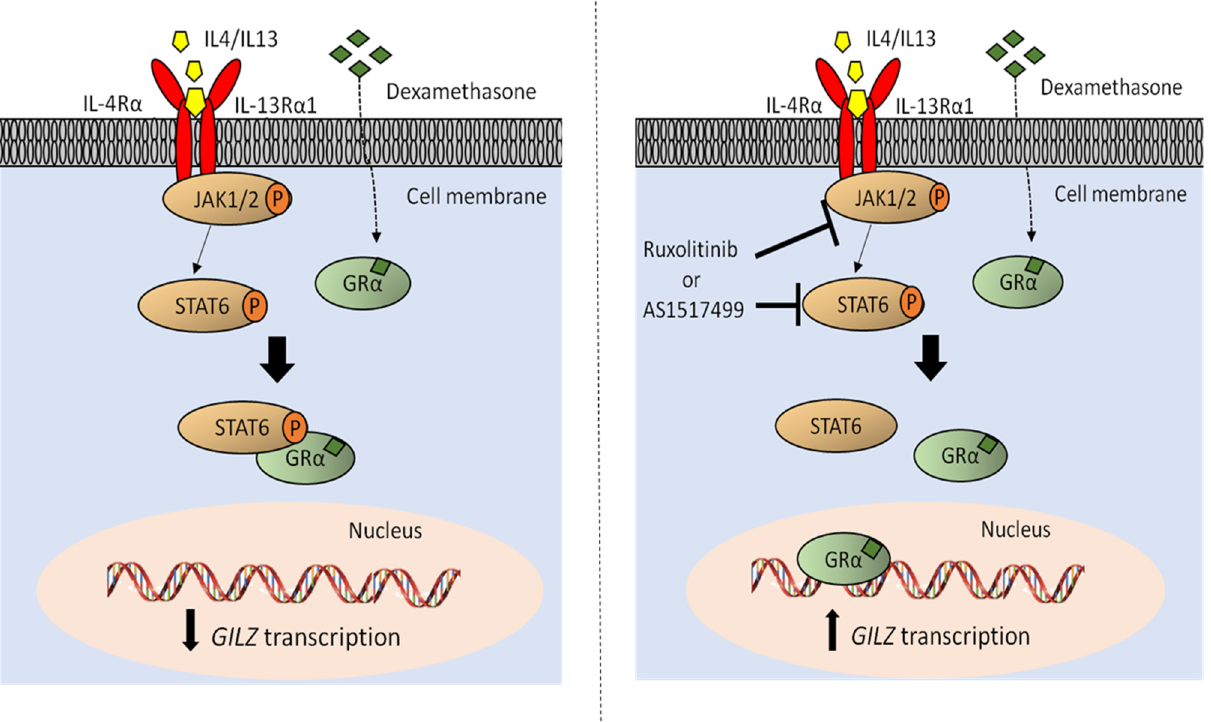
Figure 6. Schematic representation of the JAK1/2-STAT6 pathway and its interaction with GR protein. On the left, the kinases JAK1/2, once activated by the binding of IL-4 or IL-13 to their receptors, can phosphorylate STAT6 in Y641, which in turn sequestrates GR that cannot transcribe its pro-apoptotic genes making these cells more resistant to dexamethasone treatment. On the right the inhibition of JAK1/2 or STAT6 Y641 phosphorylation by ruxolitinib or AS1517499, respectively, allows the GR to bind to the DNA, thus promoting the transcription of its target genes, such as GILZ , making these cells more sensitive to dexamethasone treatment.